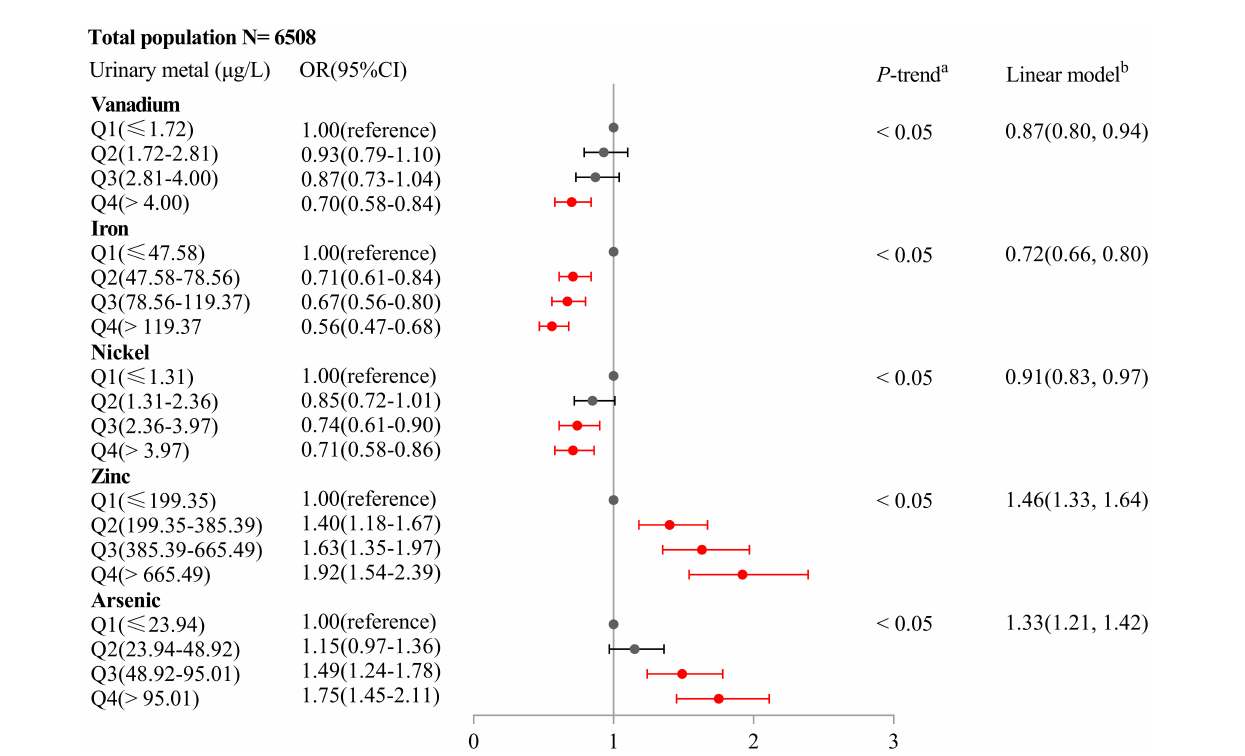
FIGURE1 Association of an IQR increase in urinary metal concentrations of vanadium, iron, nickel, zinc, and arsenic with hyperuricemia risk (Odds ratio and 95% confidence interval). Unconditional stepwise logistic regression models were performed and adjusted for age, gender, education level, marital status, active smoking status, passive smoking status, drinking status, hypertension, diabetes, hyperlipidemia, BMI, eGFR, and urine creatinine.